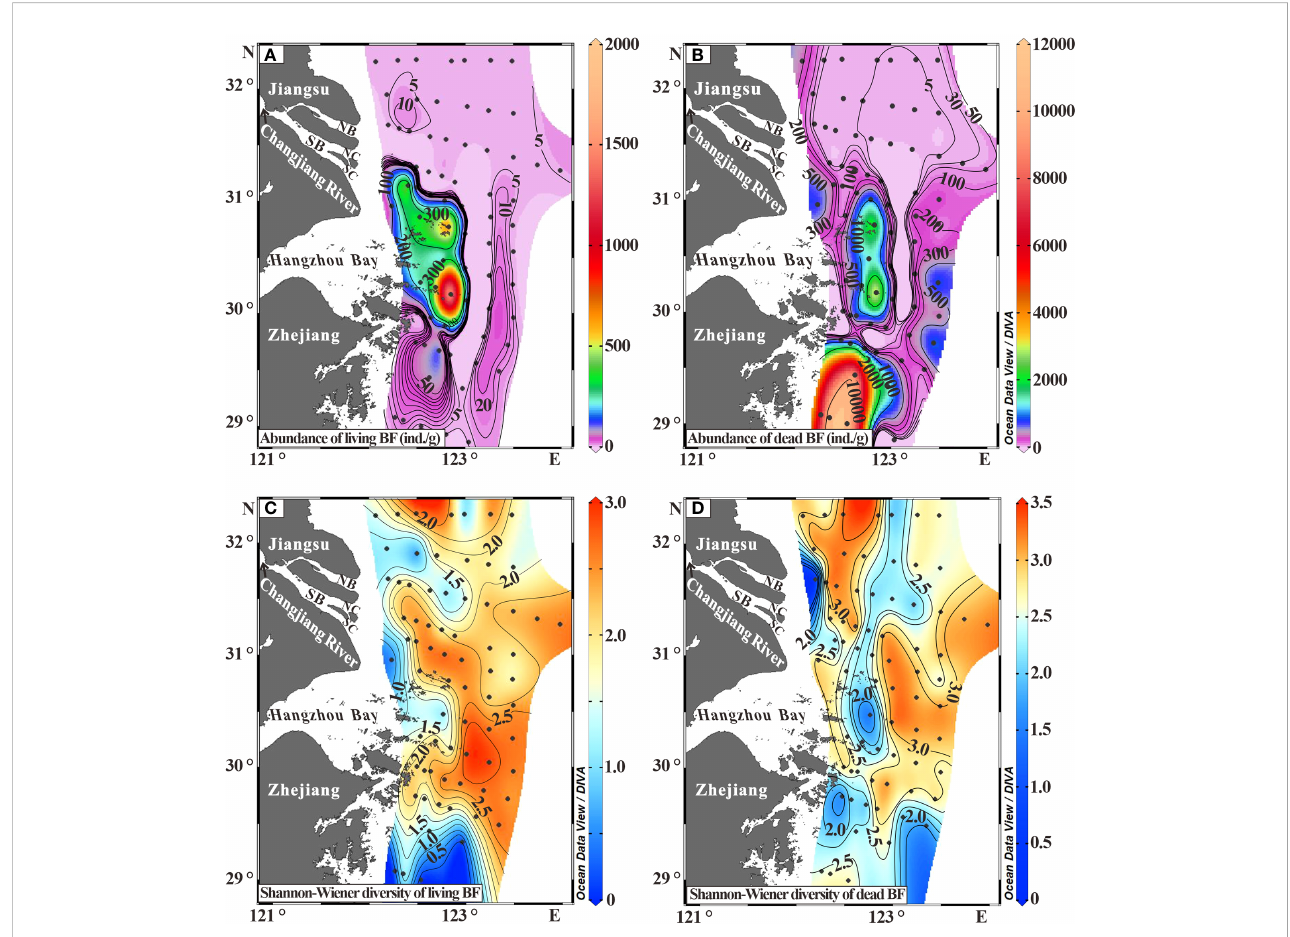
FIGURE 3 Distribution of living and dead benthic foraminiferal abundance (A , B) , and distribution of Shannon-Wiener diversity (H ′ ) of living and dead benthic foraminiferal fauna (C , D) . Detailed data are included in Supporting Information Table